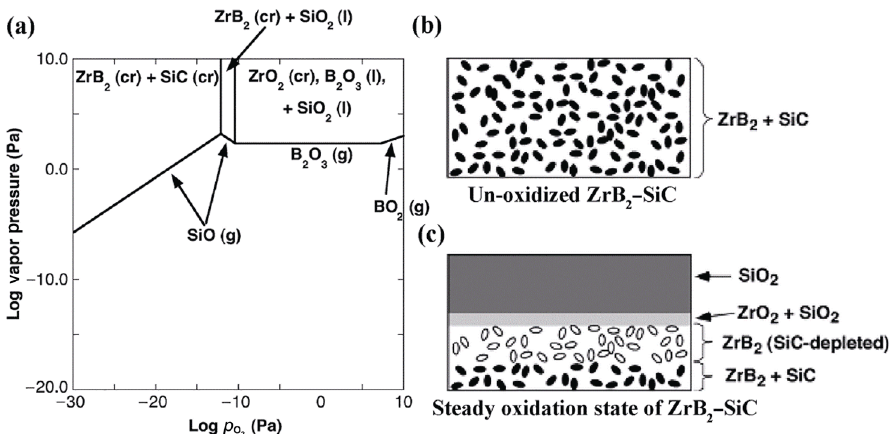
Fig. 12 Volatility diagram of ZrB 2 –SiC at 1500 ℃ (a), schematic diagram of un-oxidized ZrB 2 –SiC (b), and the steady oxidation state of ZrB 2 –SiC at 1500 ℃ (c). Reproduced with permission from Ref. [164], © The American Ceramic Society